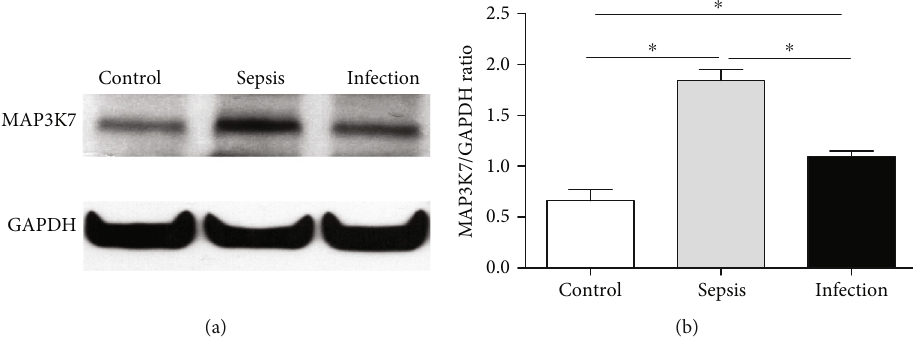
Figure 5: MAP3K7 expression in PBMC of sepsis patients with respect to infection and control. PBMC were collected from sepsis patients, infection patients, and healthy controls at admission. MAP3K7 protein expression in PBMC was examined via Western blot analysis. (a) A representative Western blot is shown. (b) Data are presented as mean ± SEM , n = 6 . ∗ p < 0 : 05